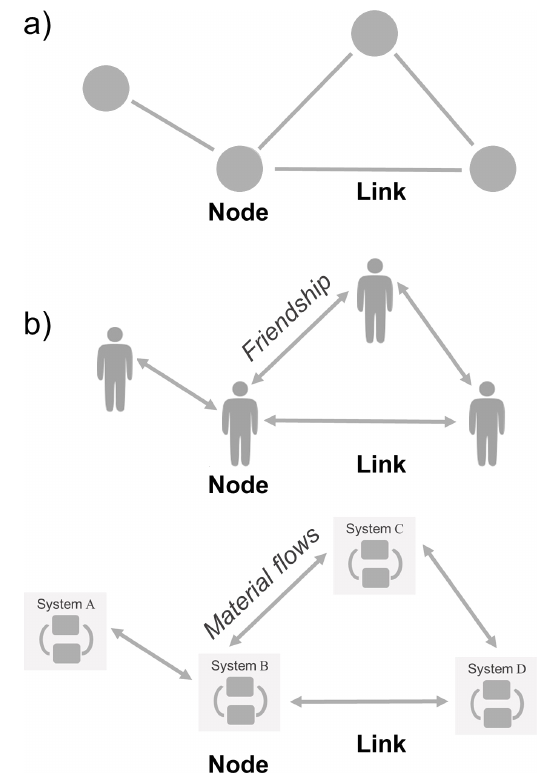
of the content and the level of aggregation they represent (Bodin et al. 2019). Nodes can, for example, represent people in a social network or countries in a trade network. Similarly, links can indicate friendships between people or commodity flows between countries. In this sense, telecoupled phenomena can also be viewed as networks, for example, with social-ecological systems as nodes and flows as links (see Fig. 2). Nodes and links can thus Fig. 2 . (a) Node-link structure of networks. (b) Network examples: actor networks and networks of social-ecological systems. Source: Authors, inspired by Barabási